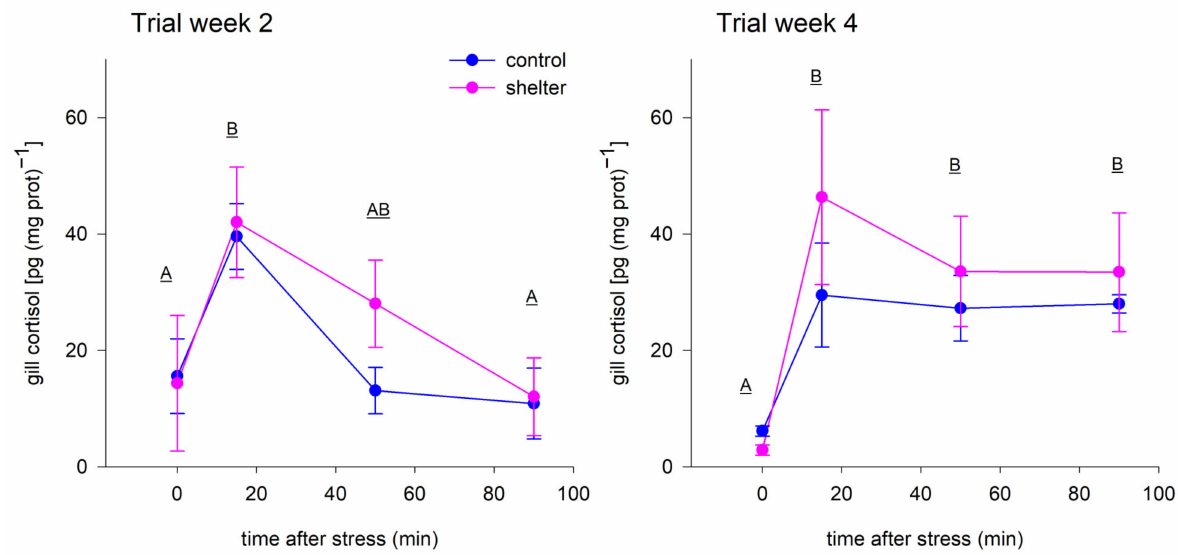
Figure 5. Gill levels of cortisol of rainbow trout ( Oncorhynchus mykiss ) fingerlings from Control and Shelter groups exposed to a standardized 2 min net-chasing stressor. Fish were exposed to the stressor on two occasions: after 2 weeks (left panel) and after 4 weeks (right panel) from the start of the experimental period. Data represent the mean and SEM of n = 3 tanks per treatment. Post-stress sampling time had an effect on cortisol levels on both occasions (two-way ANOVA, p = 0.013 and p < 0.001 for week 2 and week 4 trial, respectively); differences among sampling times are indicated by different letters. The presence of shelters did not affect cortisol levels in any of the trials ( p = 0.624 and p = 0.521 for week 2 and week 4 trial, respectively). No significant time × treatment interactions were found ( p = 0.660 and p = 0.543 for week 2 and week 4 trial,